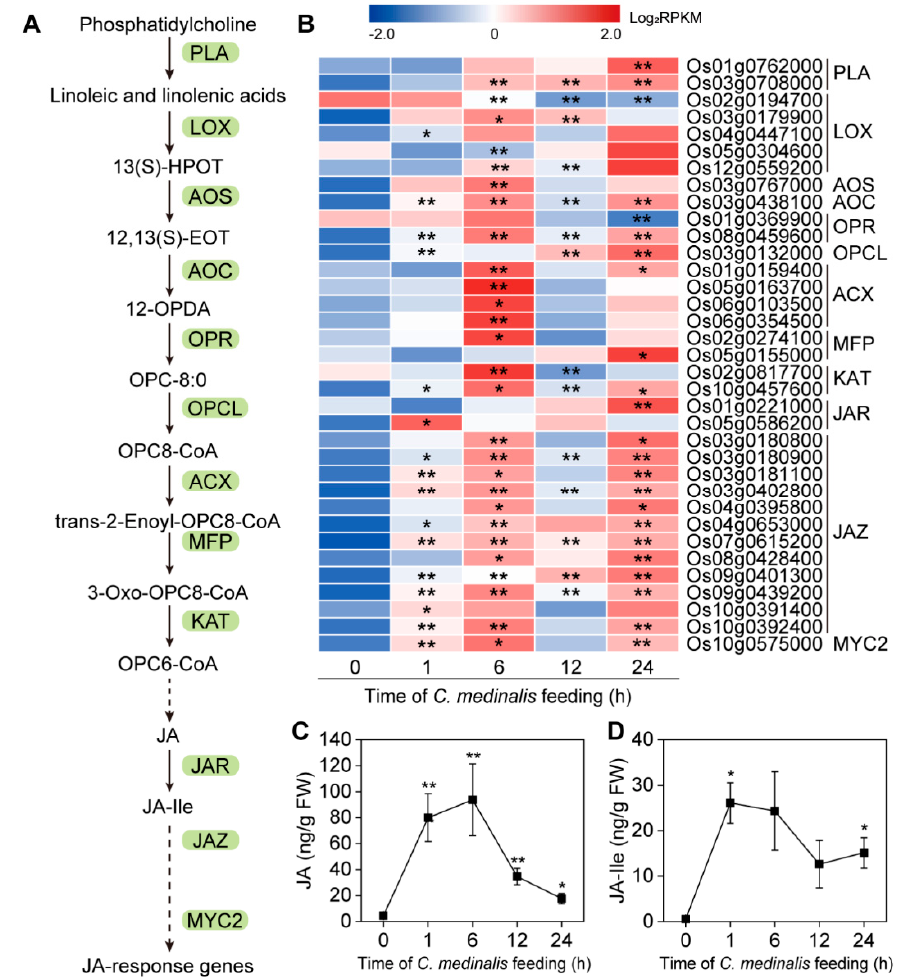
Figure 8. C. medinalis -induced responses in the jasmonic acid (JA) pathway. ( A ) Overview of the JA pathway. ( B ) Heat map of the expression of genes associated with the JA pathway. Asterisks indicate a significant difference of the expression of genes at different time points relative to control (0 h): * padj < 0.05, ** padj < 0.01 via the Benjamini and Hochberg adjustment method. ( C ) JA and ( D ) JA-isoleucine conjugate (JA-Ile) contents (ng/g FW) in rice leaves. Values are mean ± SE of three biological replicates. Asterisks indicate statistically significant differences compared to time zero: * p values < 0.05, ** p -values < 0.01 (Student’s t test). phospholipase A1 (PLA); lipoxygenase (LOX); 13(S)-hydroperoxylinolenic acid (13(S)-HPOT); allene oxide synthase (AOS); 12,13(S)-epoxylinolenic acid 12,13(S)-EOT); allene oxide cyclase (AOC); 12-oxo-phytodienoic acid (12-OPDA); 12-oxophytodienoate reductase (OPR); 3-oxo-2-(2 (cid:48) (Z)-pentenyl)-cyclopentane-1-octanoic acid (OPC-8:0); OPC8-CoA ligase (OPCL); acyl-CoA oxidase (ACX); multifunctional protein (MFP); 3-ketoacyl-CoA thiolase (KAT); jasmonate resistant (JAR); jasmonate-ZIM domain